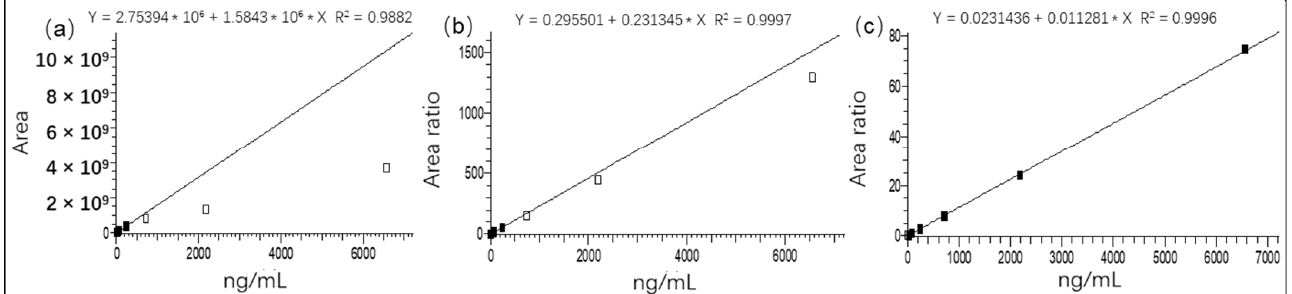
Figure 4. Calibration curves of ENR with the external method ( a ), ENR-d5 ( b ), and ENR-d3 ( c ) for internal calibration.